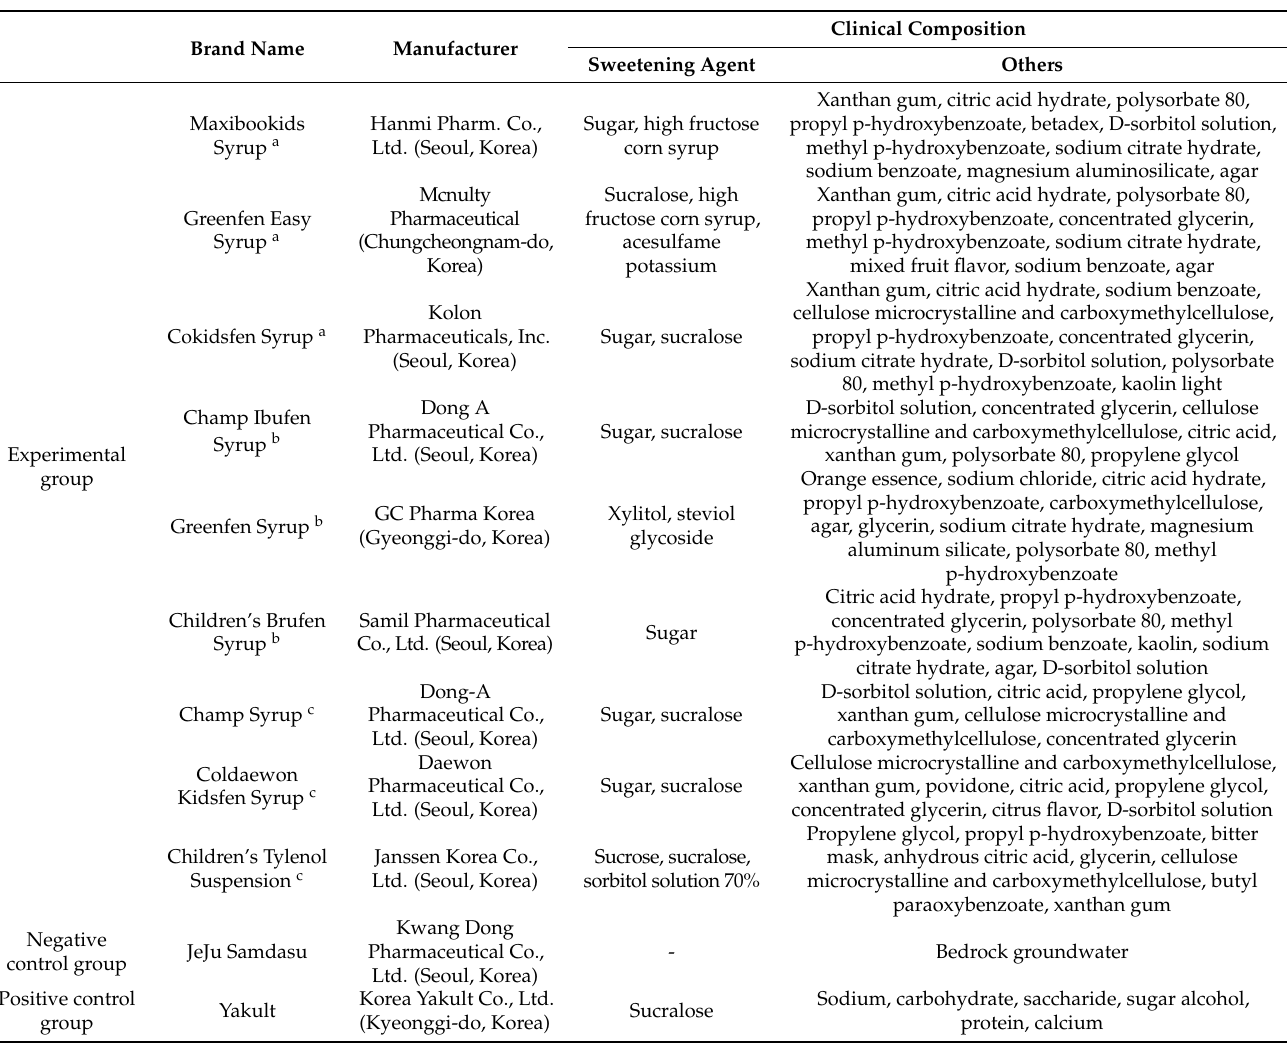
Table 1. Experimental groups’